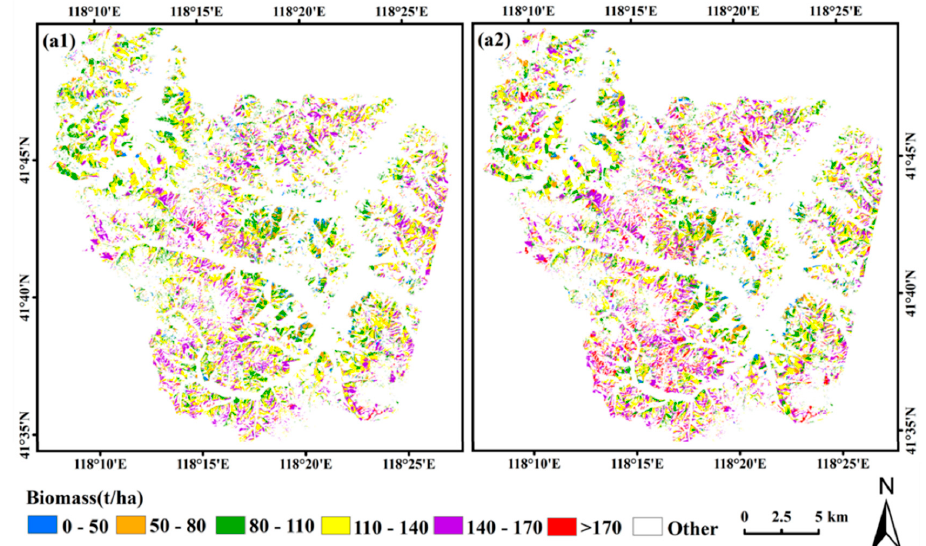
Figure 7. A comparison of aboveground biomass spatial distribution using only spectral signature ( a1 ) and using a combination of spectral and forest canopy features ( a2 ), showing more pixels with high aboveground biomass values in ( a2 ) than in ( a1